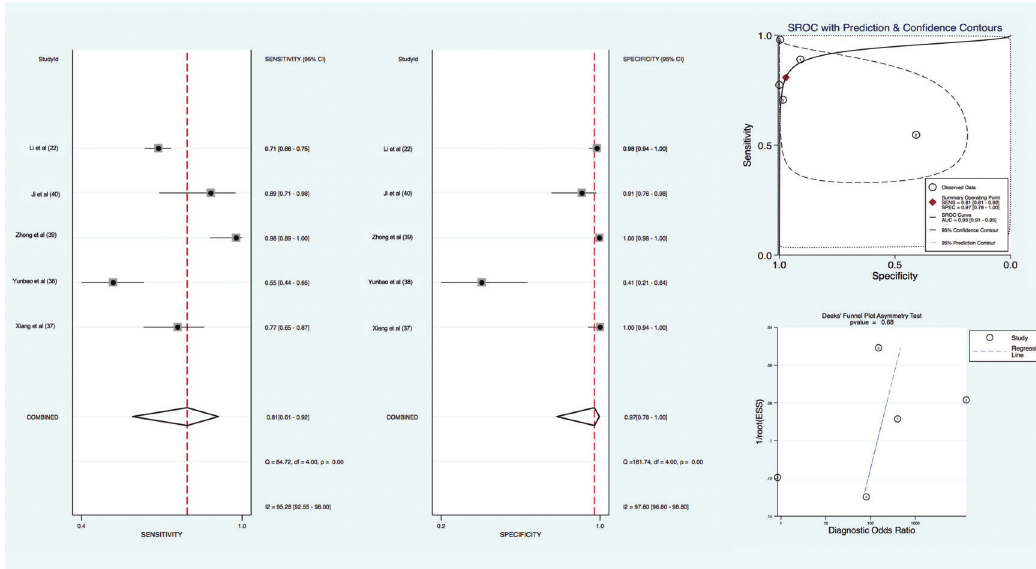
Figure 2 - IgG test pooled diagnostic value for diagnosis of SARS-CoV-2 infection.